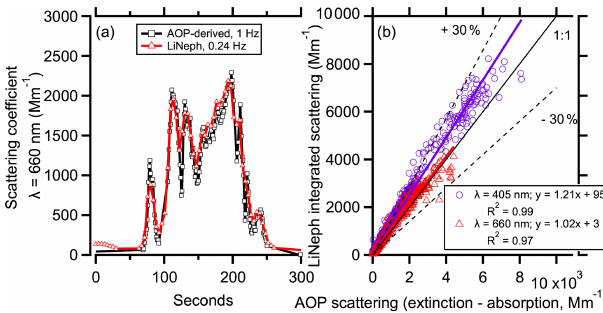
Figure 6. (a) The time series of aerosol scattering at 660nm mea- sured by the LiNeph (red triangles) and calculated from the AOP suite measurements (black squares). The Pearson correlation coeffi- cient is 0.96. (b) The integrated scattering measured by the LiNeph as a function of the scattering derived from the AOP measurements. Red triangles and purple circles show measurements at 660 and 405nm, respectively, along with linear regression fits, shown as solid lines. A 1 : 1 line and the ± 30% bounds are shown as black solid line and two dash lines,